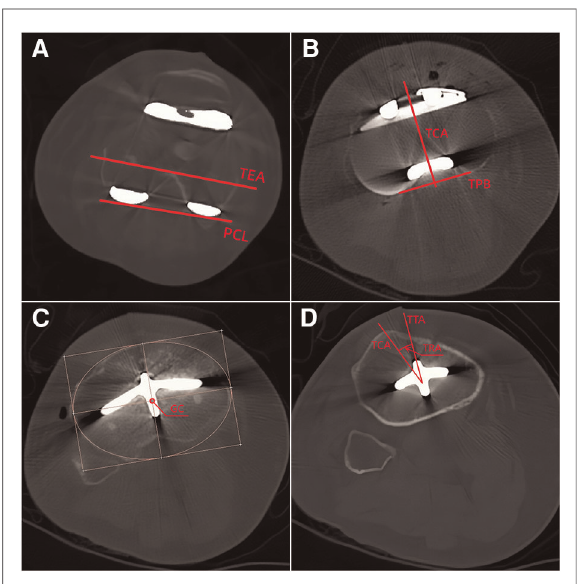
FIGURE 3 Measurement on the transverse plane ( A : TEA, trans-epicondyle axis; PCL, posterior condylar line; B : TPB, tibial posterior border; TCA, tibial component axis: the mid-perpendicular line of the TPB; C : GC, geometrical center; D : TRA, tibial rotational